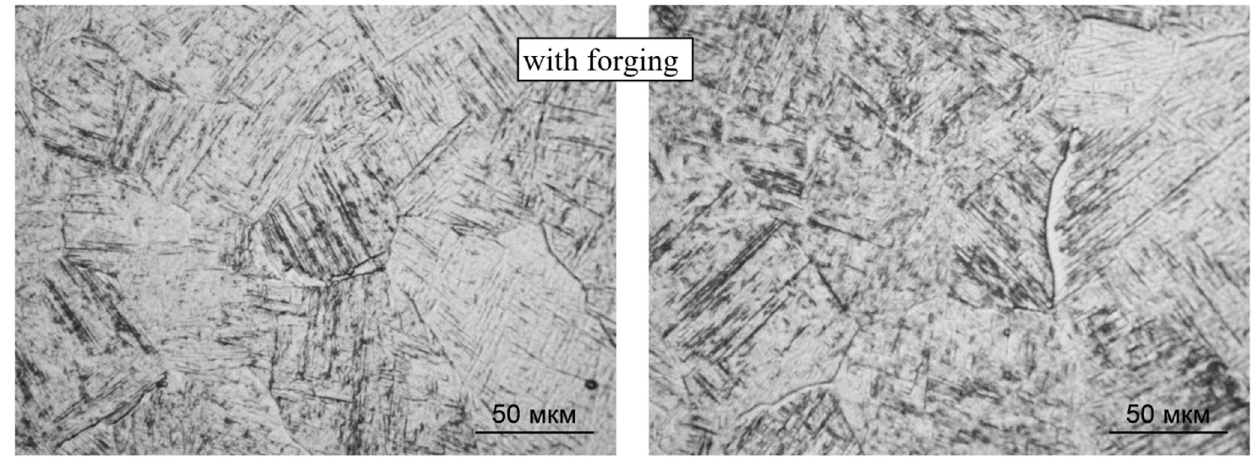
Figure 9. Boundaries between primary β -grains of CMT deposition with forging; ×500.